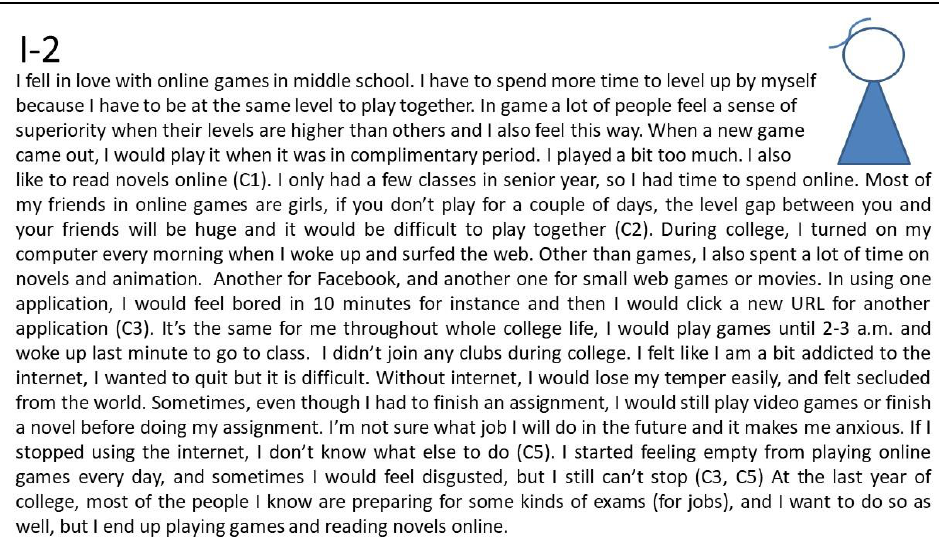
Figure 2. The person narrative about the second persona (I-2) .